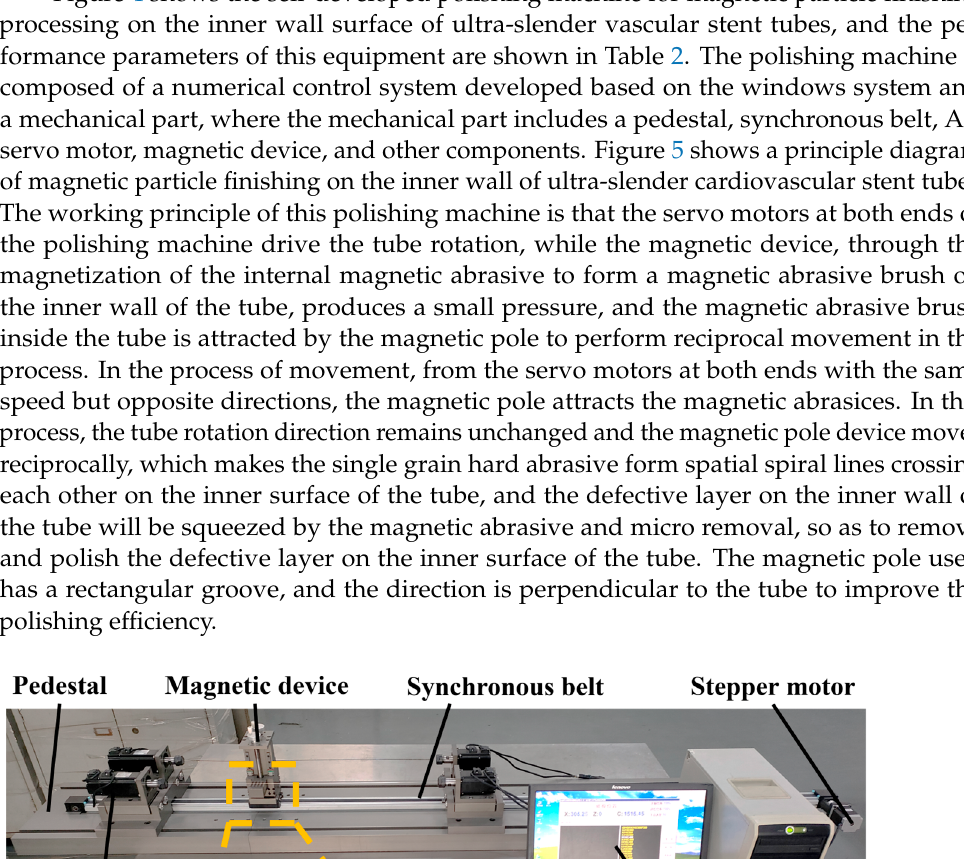
Figure 5. Principle diagram of magnetic particle finishing on the inner wall of ultra-slender cardio- vascular stents tube. The steps of magnetic abrasive finishing of ultra-long cardiovascular support tubes are: (1) fill the tube with magnetic abrasive and cutting fluid proportionally and seal both ends; (2) clamp the tube through the precision chuck to ensure no loosening; (3) adjust the tensioning device for tightening; (4) prepare the CNC program for polishing; (5) after pol- ishing is completed, remove the seal, rinse the tube with anhydrous ethanol, and then air- dry and store in a dry place. Table 2. Equipment performance parameters. Parameter